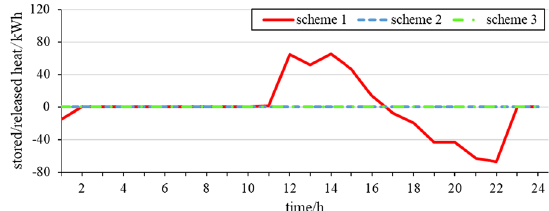
Fig. 12 Dynamic change of heat storage/release of the tank in summer